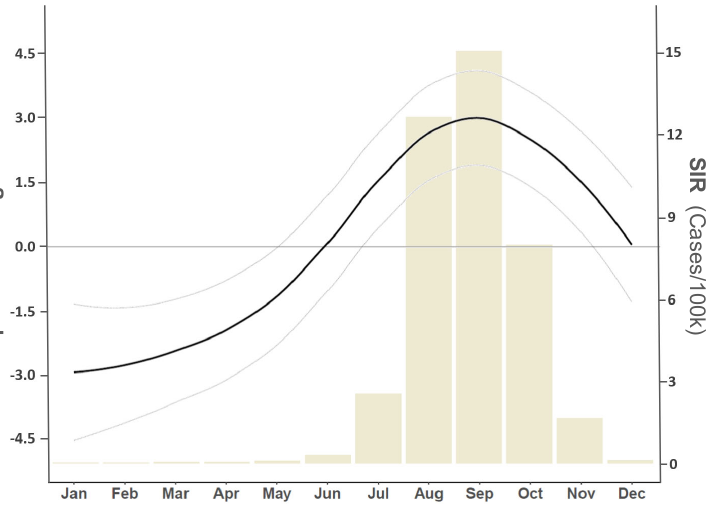
Figure 8. Temporal distribution of equine WND relative risk. Vertical axis at left describes model estimated log-risk (absolute risk, case counts on the log scale) and corresponds to smooth curve re- flecting intra-annual changes in case intensity. Light gray lines surrounding smooth curve demarcate the estimated 95% CI. Horizontal gray line intersecting 0 (zero) on the left vertical axis represents the US annual median case rate of 3.88 (1.83, 6.67 CI) cases/100,000 horses. Horizontal axis at bottom lists the month of year. Bar chart in background corresponds to right vertical axis providing monthly standardized incidence rates